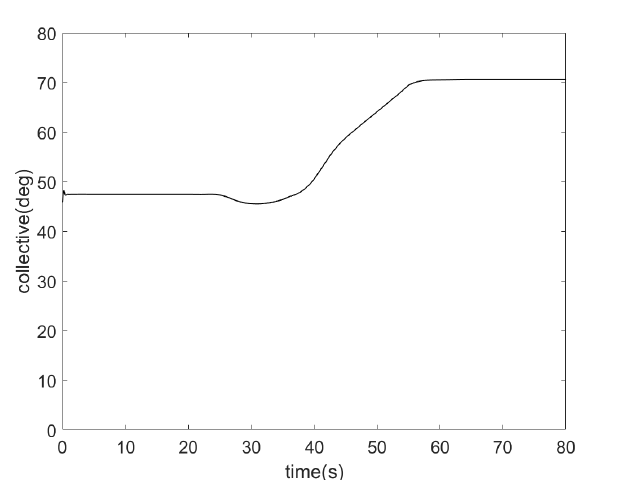
Figure 14. The time evolution of the height.